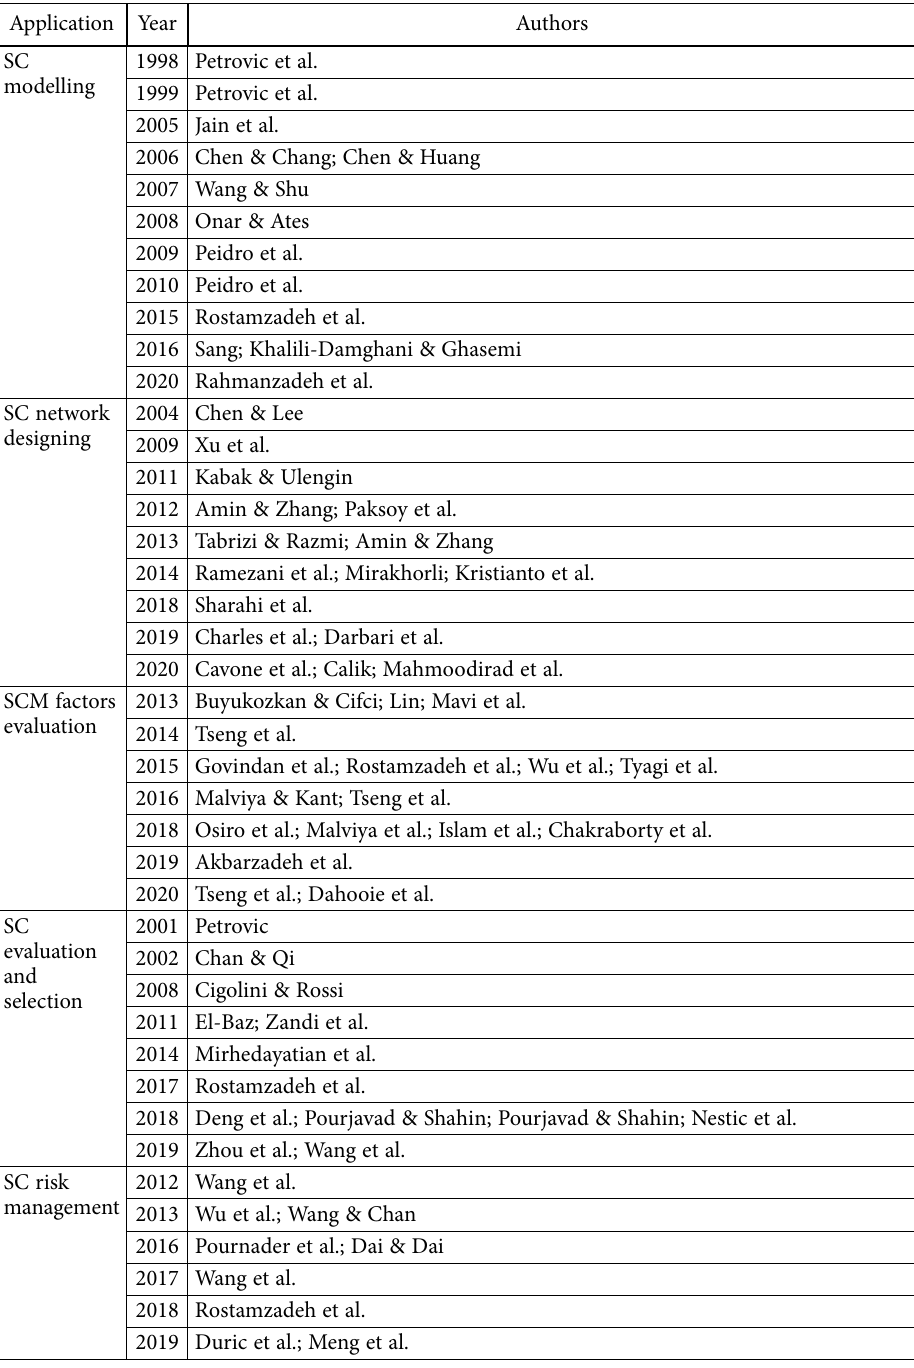
Table 7. Literature on fuzzy methods in SC system optimization and supplier